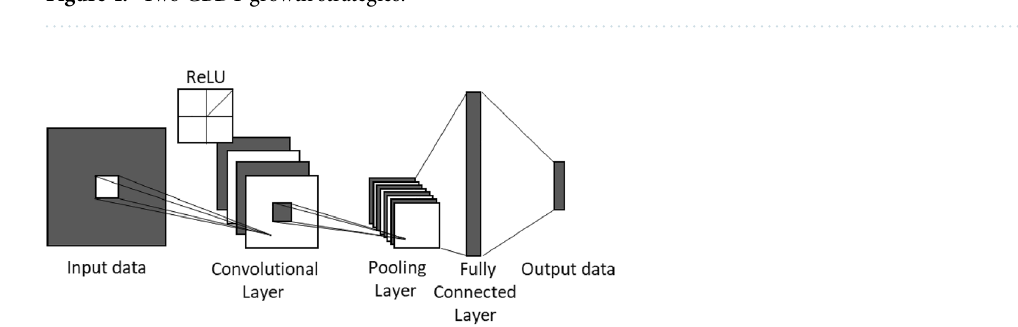
Figure 4. Two GBDT growth strategies.